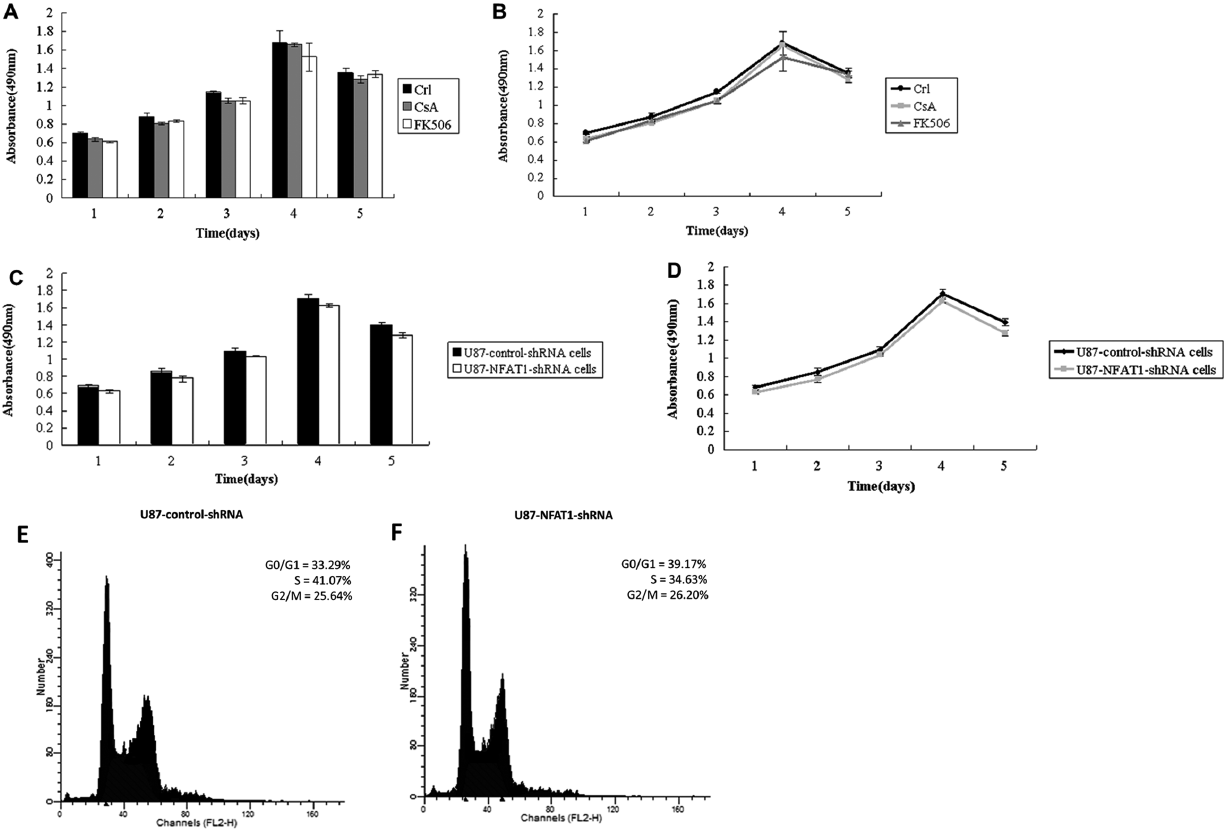
Figure 4. Effect of NFAT1 inhibition by CsA or FK506 on proliferation of GBM U87 cells (A and B). Effect of NFAT1 down-regulation on proliferation of GBM U87 cells (C and D). The cells were plated in triplicate. The graphs are representative of three independent experiments. E-F: Cell cycle was analyzed by the incorporation of PI. The cells were seeded in triplicate and analyzed 24 h after plating by flow cytometry. The percentage of cells in each phase of the cell cycle is indicated in the graphs. Down-regulation of NFAT1 had no detectable effect on the cell cycle of U87 cells.